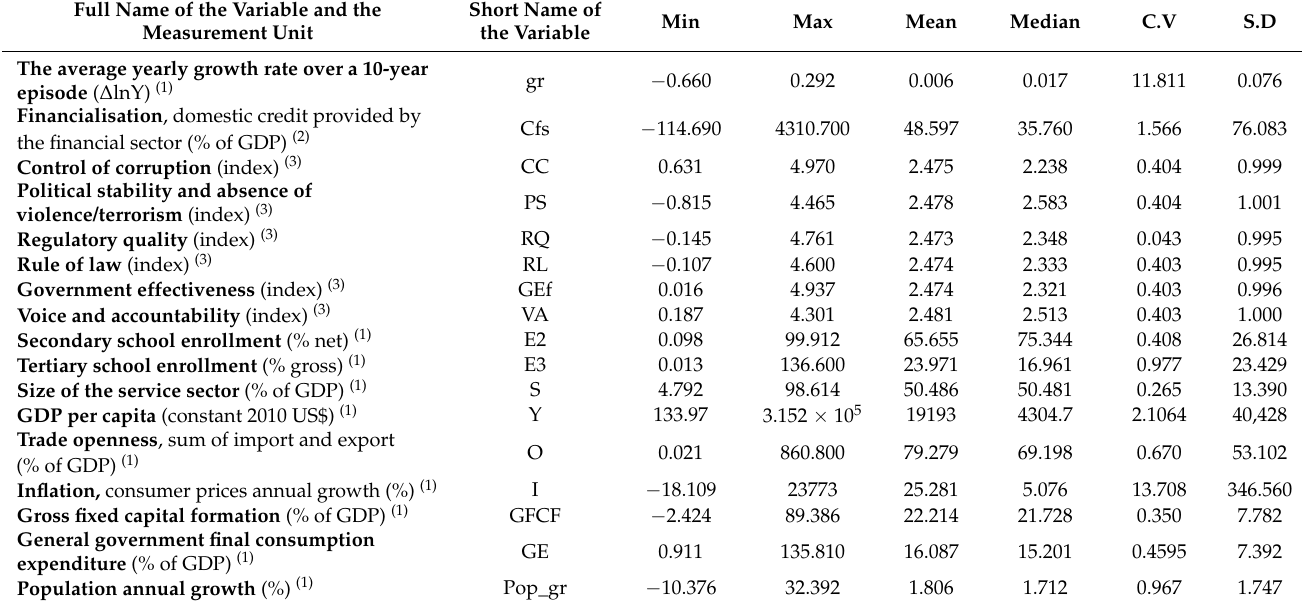
Table 1. Descriptive statistics of the raw